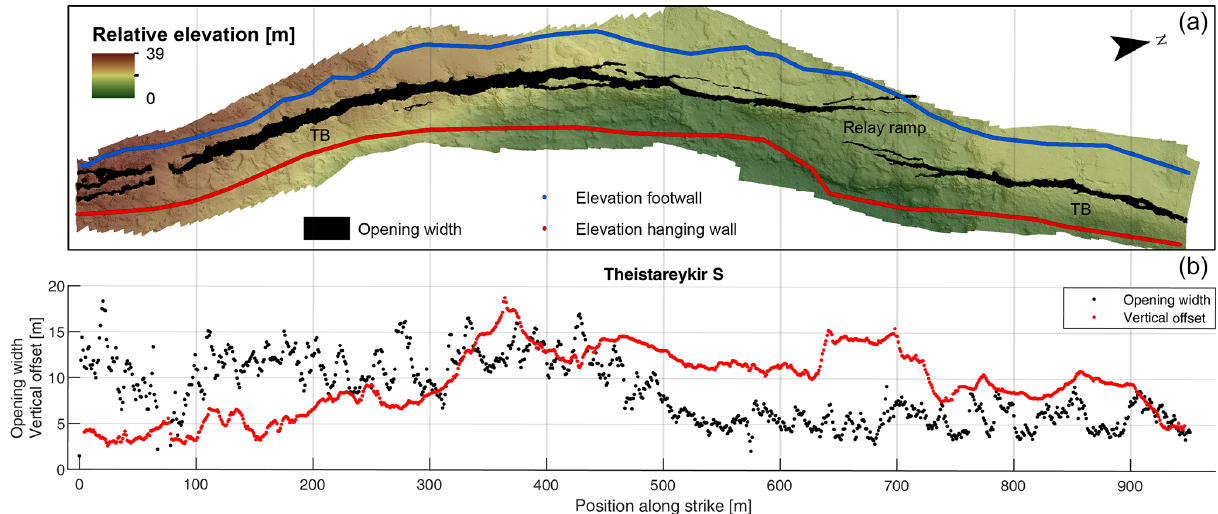
Figure 9. Fracture associated with the Theistareykir fissure swarm. (a) DEM with the mapped opening width of the fractures and elevation extraction points. (b) Opening width (black) and vertical offset (red) plotted along strike. The x -axis scale is analogous to the scale in the DEM in panel (a) ; 65 ◦ 50 (cid:48) 45 (cid:48)(cid:48) N, 17 ◦ 00 (cid:48) 23 (cid:48)(cid:48) W. Projection of the DEM: WGS1984 UTM 28N.